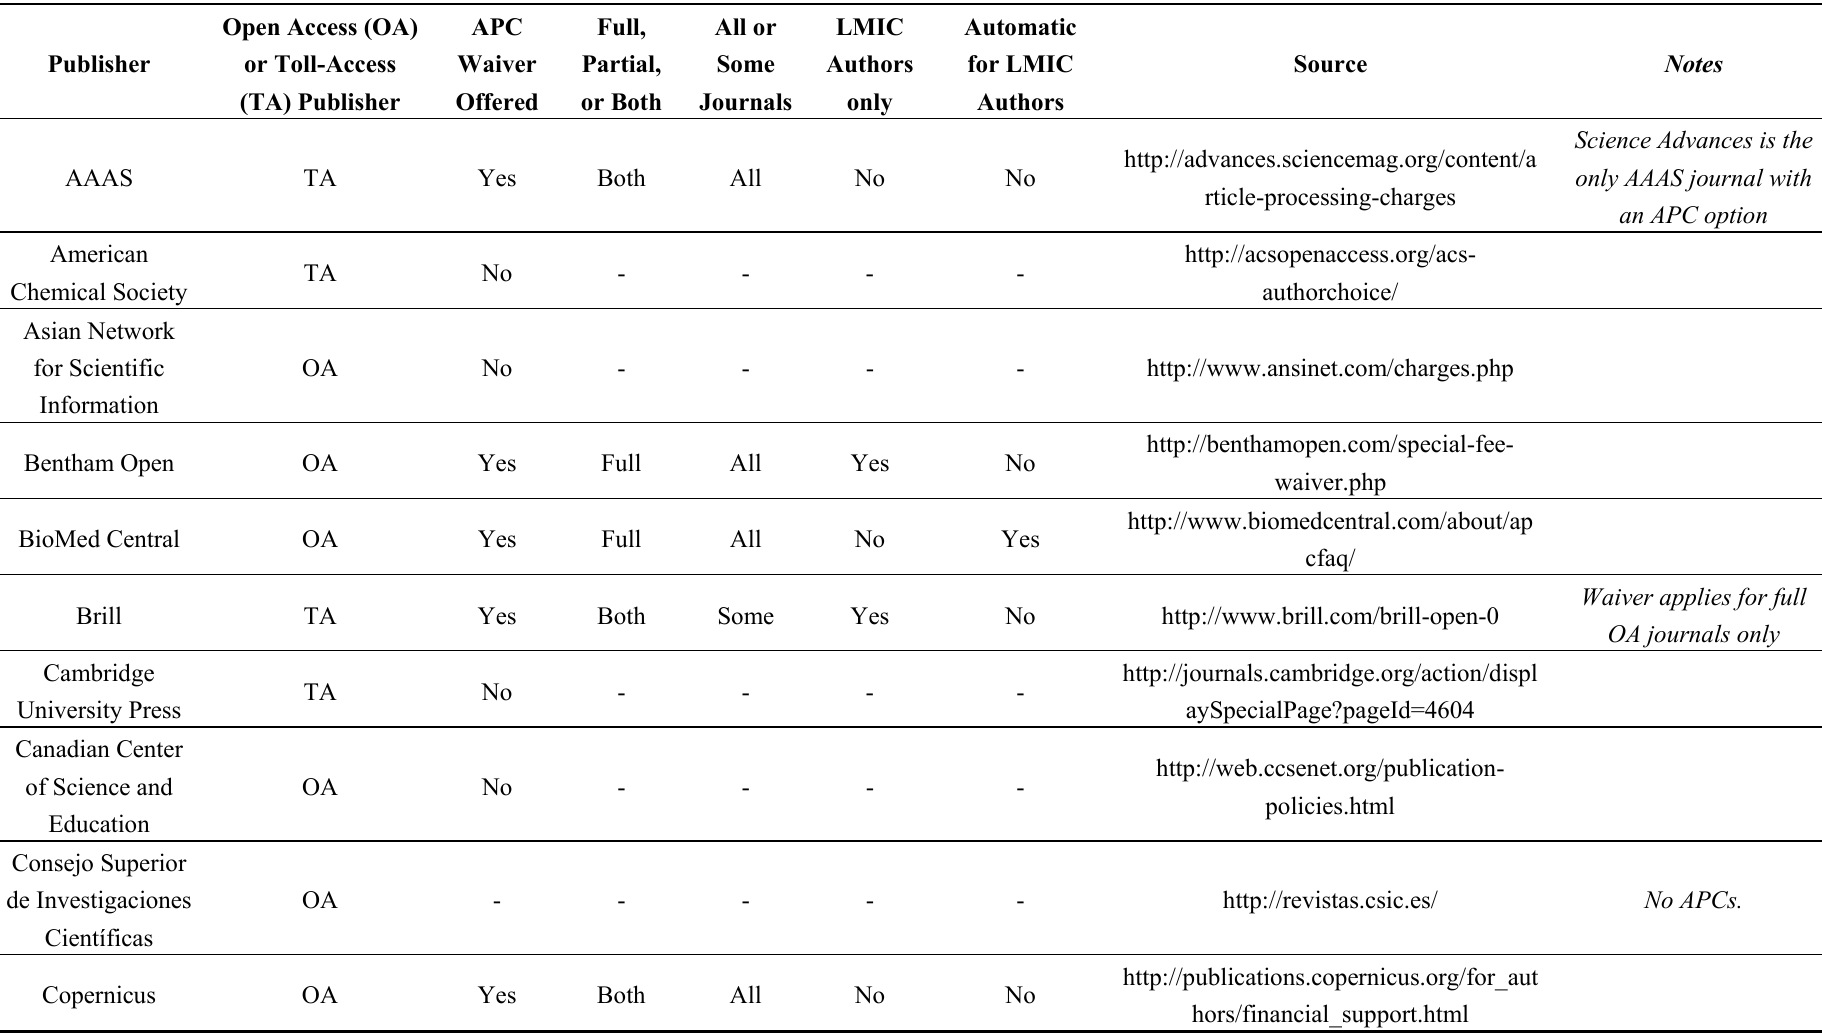
Table 3. APC fee waivers by